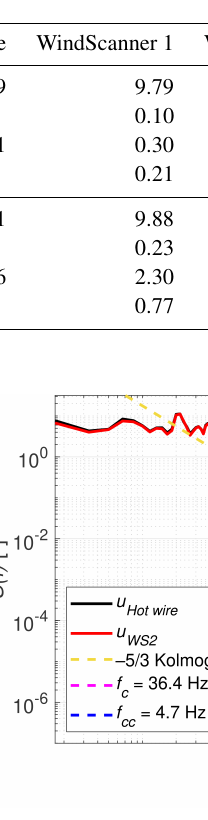
Figure 11. Spectrum of WindScanner 2 and the hot-wire anemome- ter for a turbulence intensity of 3% (Case 1a).